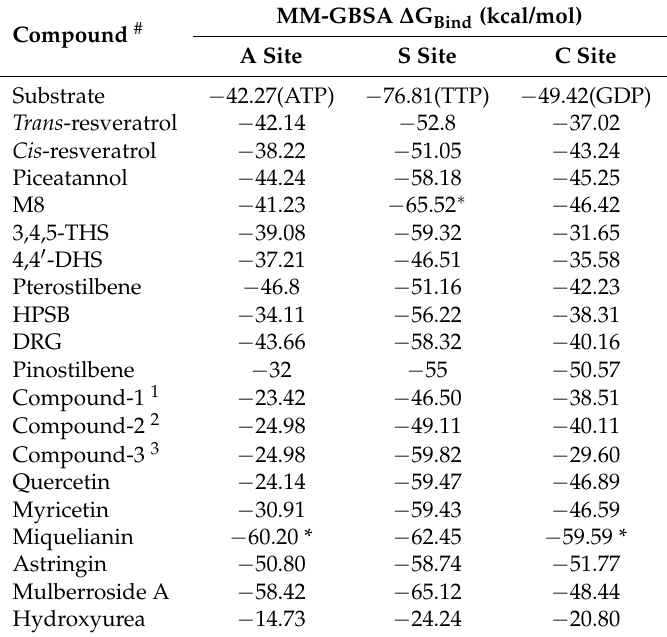
# The structure of the 19 compounds are shown in Figure S1. * The most effective binder to DNA polymerase α among 19 compounds tested. 1 Compound-1: (E)-5-(4-Nitrostyryl)benzo[d][1,3]dioxole. 2